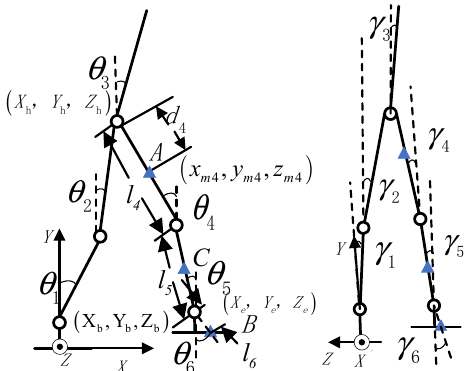
Figure 2. Side view and front view of human lower rigid-body kinematics model .